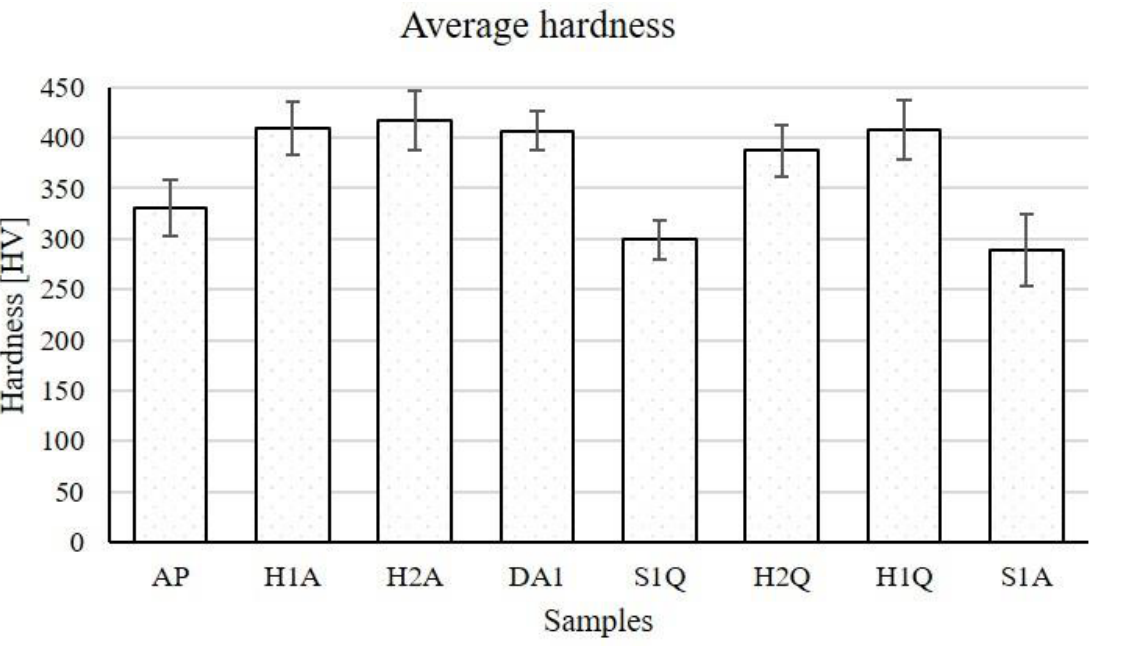
Figure 12. The average hardness of all specimens Figure 12. The a verage hardness of all specimens tested.